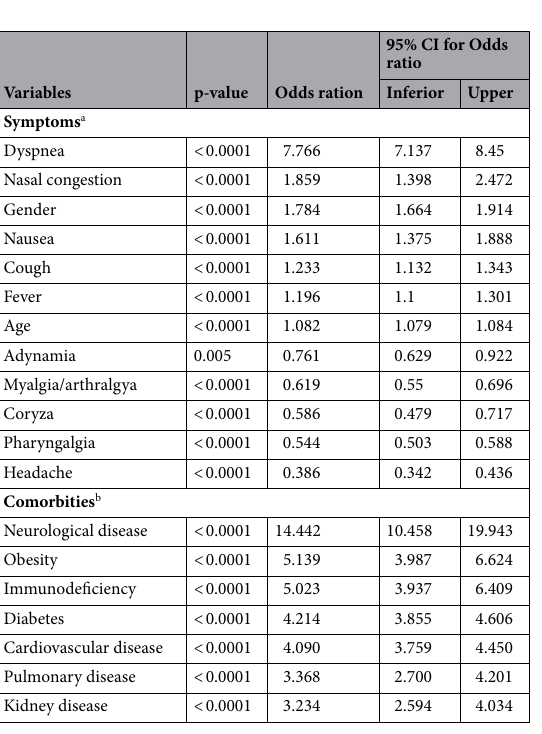
Table 2. Predicting variables of risk for death in SARS-CoV-2 infection in the population of the State of Pará-Amazônia-Brazil, 2020. Source: OpenDataSUS, Ministry of Health. Logistic Regression model: a ( χ 2 (12) = 14,646,45; p-value < 0.0001; R 2 Nagelkerke = 0.423), b ( χ 2 (7) = 3834,89; p-value < 0.0001; R 2 Nagelkerke =